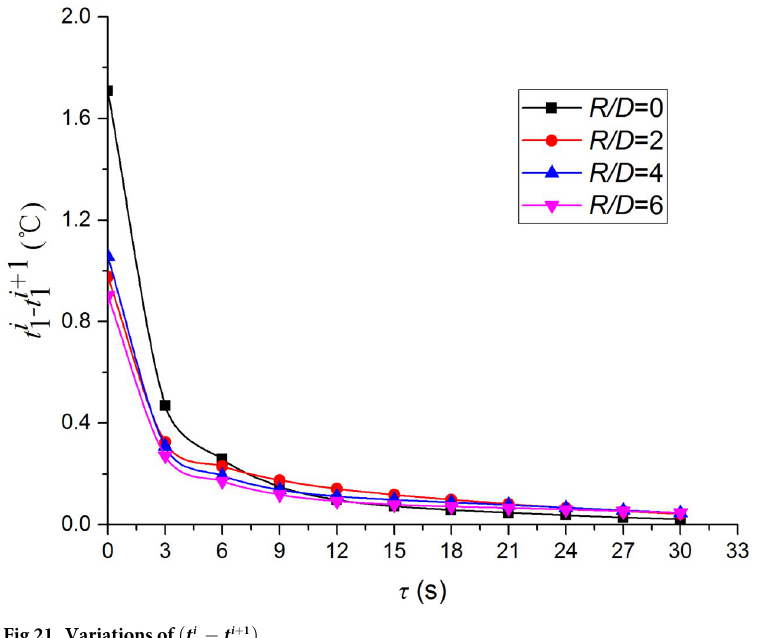
Fig 21. Variations of ð t i